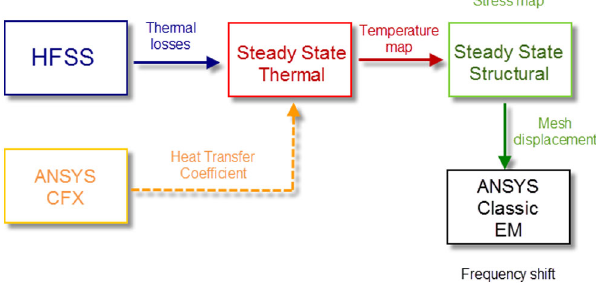
FIG. 9. Multiphysics analysis scheme based on HFSS and ANSYS .